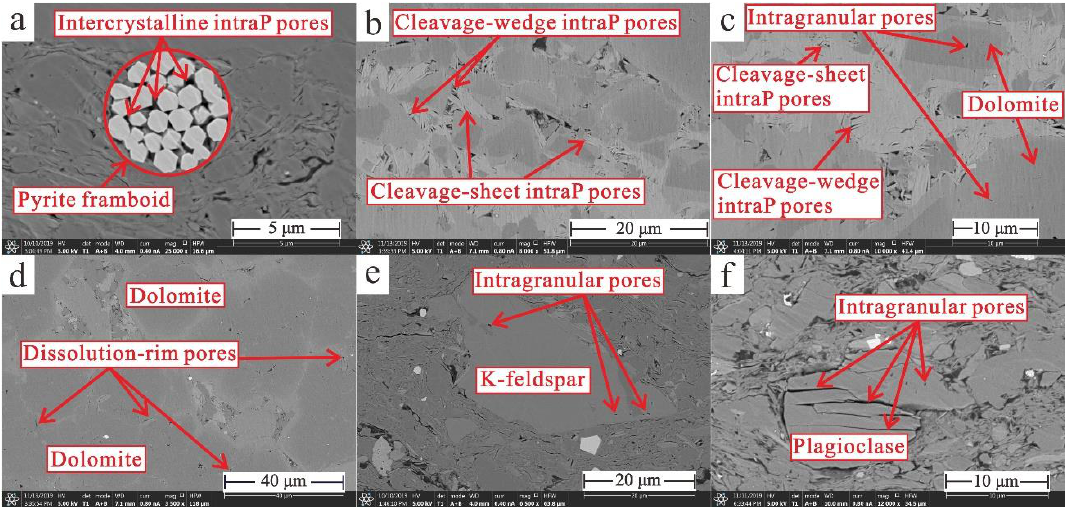
Figure 4. FE-SEM images of intraparticle pores. ( a ) SK1S16, mudstone; ( b ) SK1S25, mudstone; ( c ) SK1S25, mudstone; ( d ) SK1S25, mudstone; ( e ) SK1S16, mudstone; and ( f ) SK1S36, mudstone.